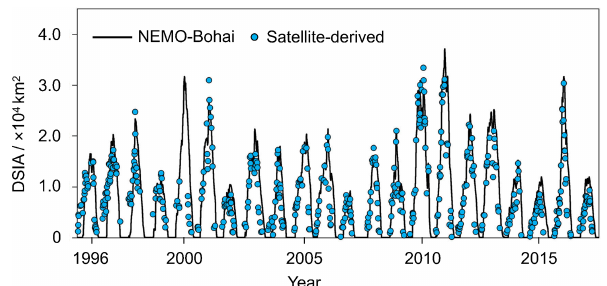
Figure 8. Comparison of daily sea ice area (DSIA) between NEMO-Bohai simulations (black line) and satellite-derived data (blue circles) from 1996 to